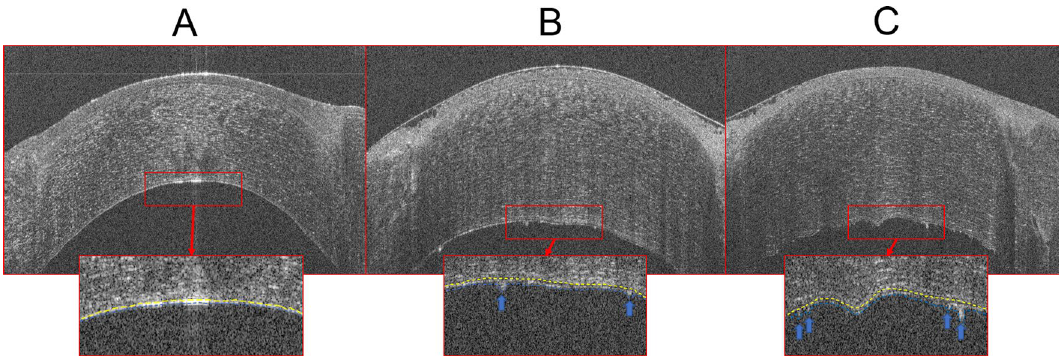
Figure 2. Chronological high-definition optical coherence tomography (HD-OCT) images of a full-thickness corneal transplant of one eye of the same patient (upper raw) with magnified preset images of the corresponding central endothelium (yellow-dashed line)/Descemet’s membrane (blue-dashed line) complex (En/DM, lower raw) showing: ( A) and ( B ) HD-OCT image of clinically healthy corneal graft at the 6th and 9th postoperative months, respectively, with the En/DM visualized as a band formed by 2 smooth hyperreflective lines with a translucent space in between in ( A ), and as a thickened band bounded by 2 hyperreflective lines with 2 posterior nodular excrescences (arrows) in ( B ). ( C) HD-OCT image of clinically diagnosed graft rejection at the 1-year visit showing the En/DM as a thick wavy band bounded by 2 hyperreflective lines with 4 posterior nodular excrescences